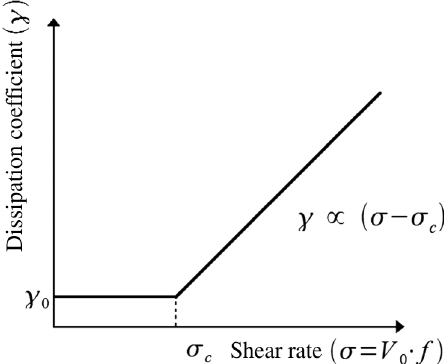
FIG. 15. Low-frequency current trace calculated from the model (1)–(7). The frequency of the driving signal is (cid:3) ¼ 5 Hz . The response is qualitatively similar to the experimental current trace of Fig. 9(a).